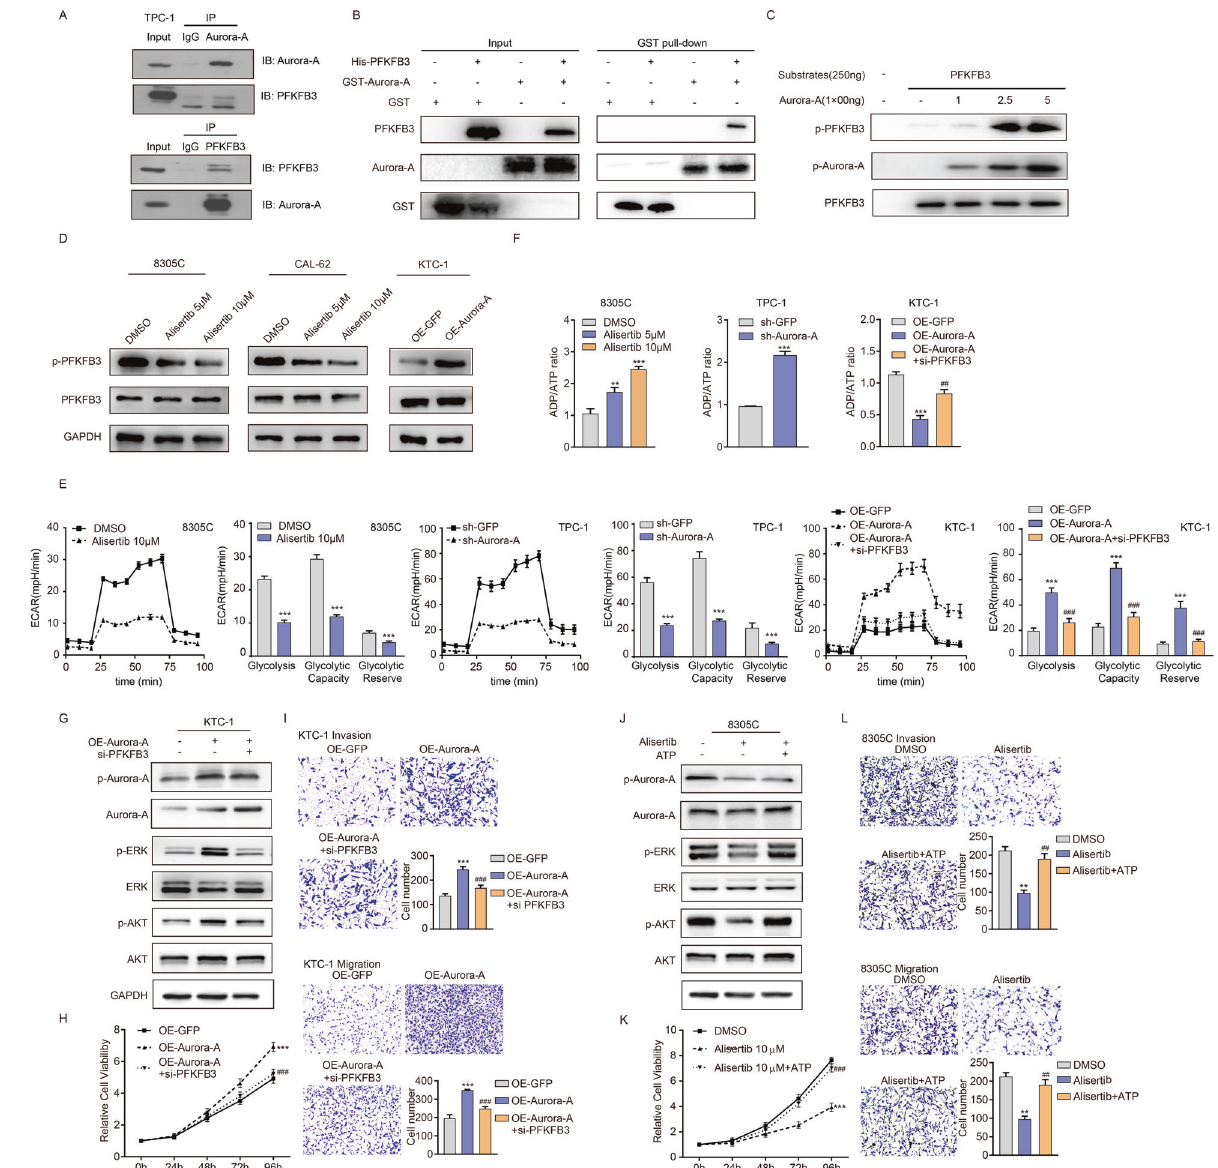
Fig. 4 Aurora-A-mediated PFKFB3 phosphorylation regulates the glycolysis of TC cells. A The interaction between Aurora-A and PFKFB3 was veri fi ed by an IP assay in TPC-1 cells. B Interaction between Aurora-A and PFKFB3 is examined by GST pull-down. C Phosphorylation level on PFKFB3 was determined by Anti-PFKFB3 (phospho S461) antibody after in vitro kinase assay. D The expression of p-PFKFB3/PFKFB3 in KTC- 1 cells with Aurora-A overexpression and Alisertib-treated 8305 C and CAL-62 cells was analyzed by western blotting. E Comparable level of glycolysis, glycolytic reserve and capacity of 8305 C, TPC-1, and KTC-1 cells measured by Seahorse XF Extracellular Flux analysis. ECAR = extracellular acidi fi cation rate. F The ADP/ATP ratio was measured in KTC-1 cells with Aurora-A overexpression or combined with siRNA targeting PFKFB3, in TPC-1 cells with Aurora-A knockdown and in 8305 C cells with Alisertib treatment, respectively. G The expression of p-Aurora-A, Aurora-A, p-ERK, ERK, p-AKT, AKT in KTC-1 cells with Aurora-A overexpression or combined with siRNA targeting PFKFB3. H , I The proliferation, migration and invasion ability in KTC-1 cells with Aurora-A overexpression or combined with siRNA targeting PFKFB3 was analyzed by CCK-8 assay ( H ) and transwell of migration and invasion assay ( I ), respectively. * P < 0.05, ** P < 0.01, *** P < 0.001, compared with control group. # P < 0.05, ## P < 0.01, ### P < 0.001, compared with Aurora-A upregulation group. J Western blotting analyzed the expression of p- Aurora-A, Aurora-A, p-ERK, ERK, p-AKT, and AKT in 8305 C cells with Alisertib treatment or combined with exogenous ATP (2 mM). K CCK-8 assays showed that Alisertib (10 μ mol) signi fi cantly inhibited cell proliferation in 8305 C, which can be remarkably restored by exogenous ATP (2 mM) supplementation. * P < 0.05, ** P < 0.01, *** P < 0.001, compared with control group. # P < 0.05, ## P < 0.01, ### P < 0.001, compared with the Alisertib-treated group. L Transwell of migration and invasion assay detected the migration and invasion ability of 8305 C cells pretreated with Alisertib for 2 days or combined with exogenous ATP (2 mM). * P < 0.05, ** P < 0.01, *** P < 0.001, compared with control group. # P < 0.05, ## P < 0.01, ### P < 0.001, compared with the Alisertib-treated group. The data are presented as the mean ± SD of three independent experiments.